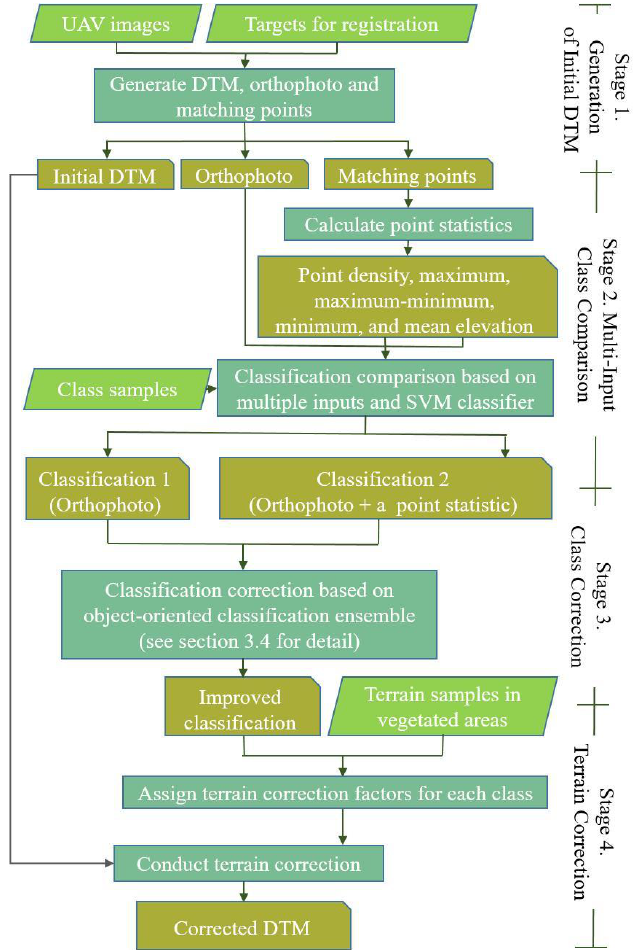
Figure 3. Conceptual overview of the object-oriented classification ensemble algorithm. The three colors demonstrated in the first three tiers represent input, process, and output result of the